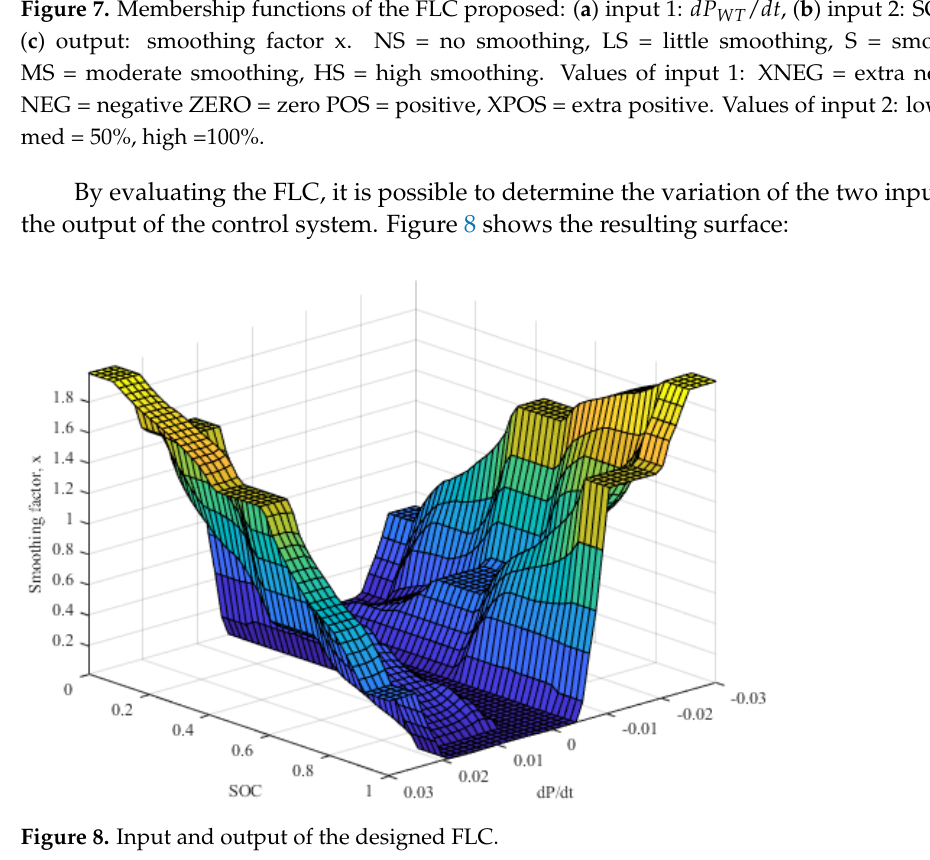
Figure 7. Membership functions of the FLC proposed: ( a ) input 1: output: smoothing factor x . NS = no smoothing, LS = little smoothing, S = smoothing, MS = moderate smoothing, HS = high smoothing. Values of input 1: XNEG = extra negative, NEG = negative ZERO = zero POS = positive, XPOS = extra positive. Values of input 2: low= 0%, med= 50%, high=100%. Table 1. Fuzzy rules.